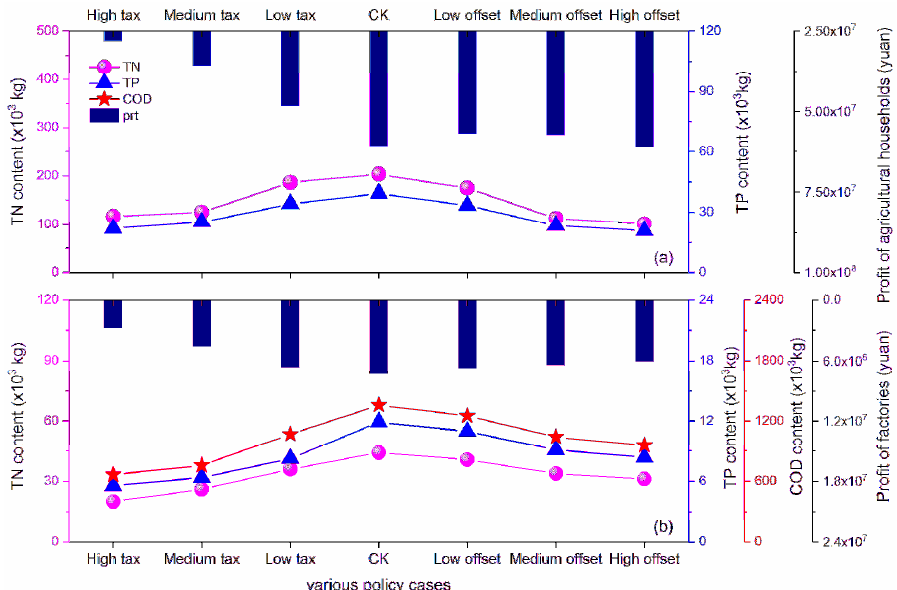
Water 2018 , 10 , x 12 of 17 Figure 5. Pollutant discharge and profits of agricultural households and factories in different scenarios: ( a ) represents TN and TP discharge into rivers and profit by agricultural household agents; and ( b ) represents TN, TP and COD discharge into rivers and profit by factory agents.